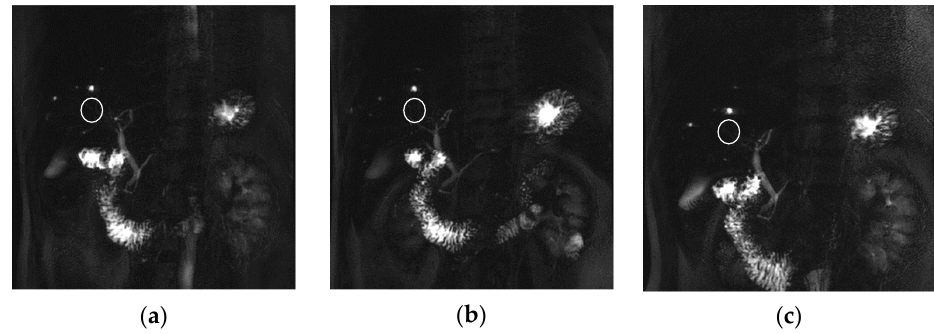
Figure 6. Patient with liver cancer. MRCP MIP images of the RT-2D-CS TSE sequence ( a ), RT-2D- SENSE TSE sequence ( b ), and BH-2D-SSh TSE sequence ( c ) images.